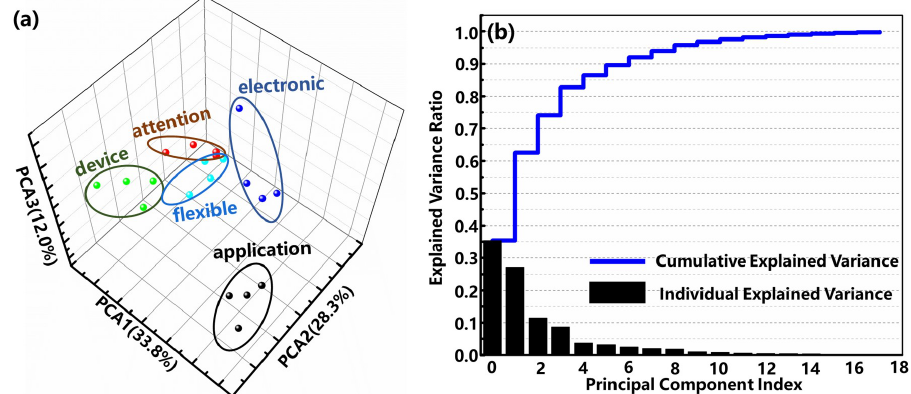
Figure 6. ( a ) PCA results of the randomly selected resistance change waveform data for the vocal cord vibrations in the coordinate system founded by the first three principal components. ( b ) Explained variance ratio of the randomly selected resistance change waveform